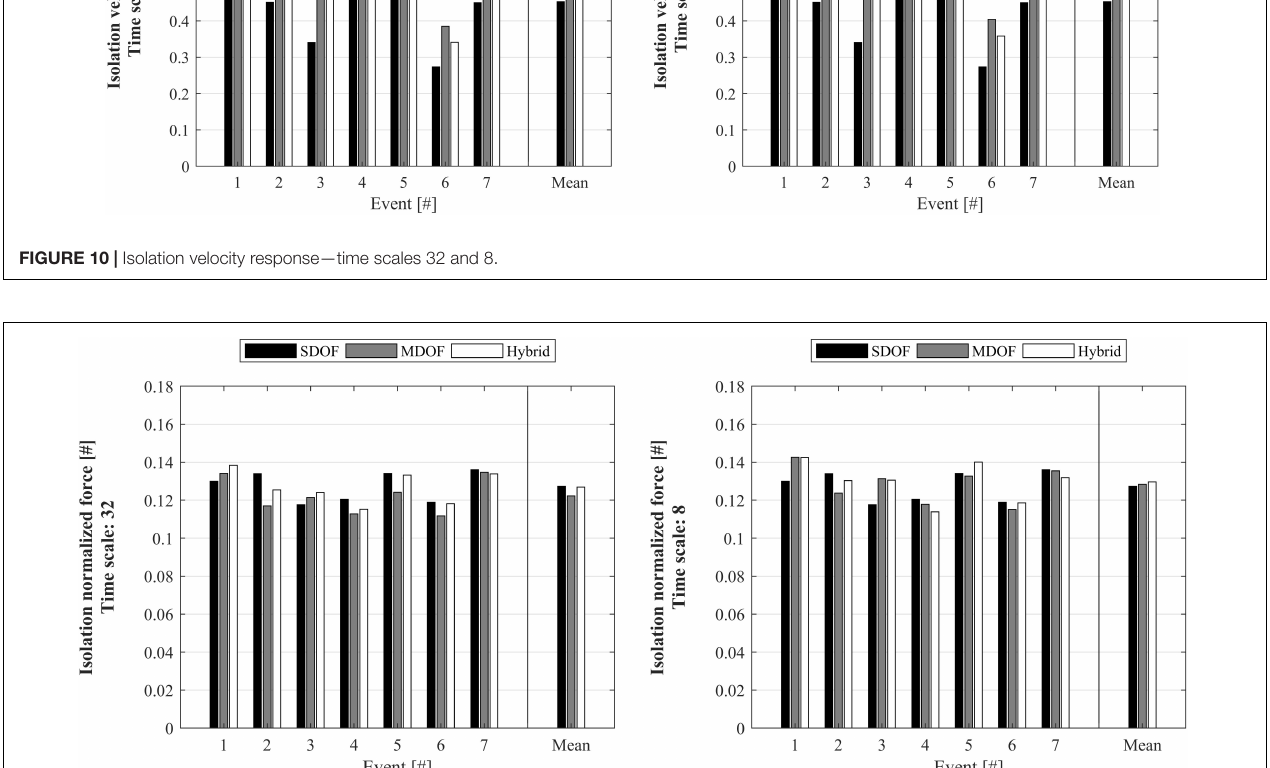
FIGURE 11 | Isolation force response—time scales 32 and